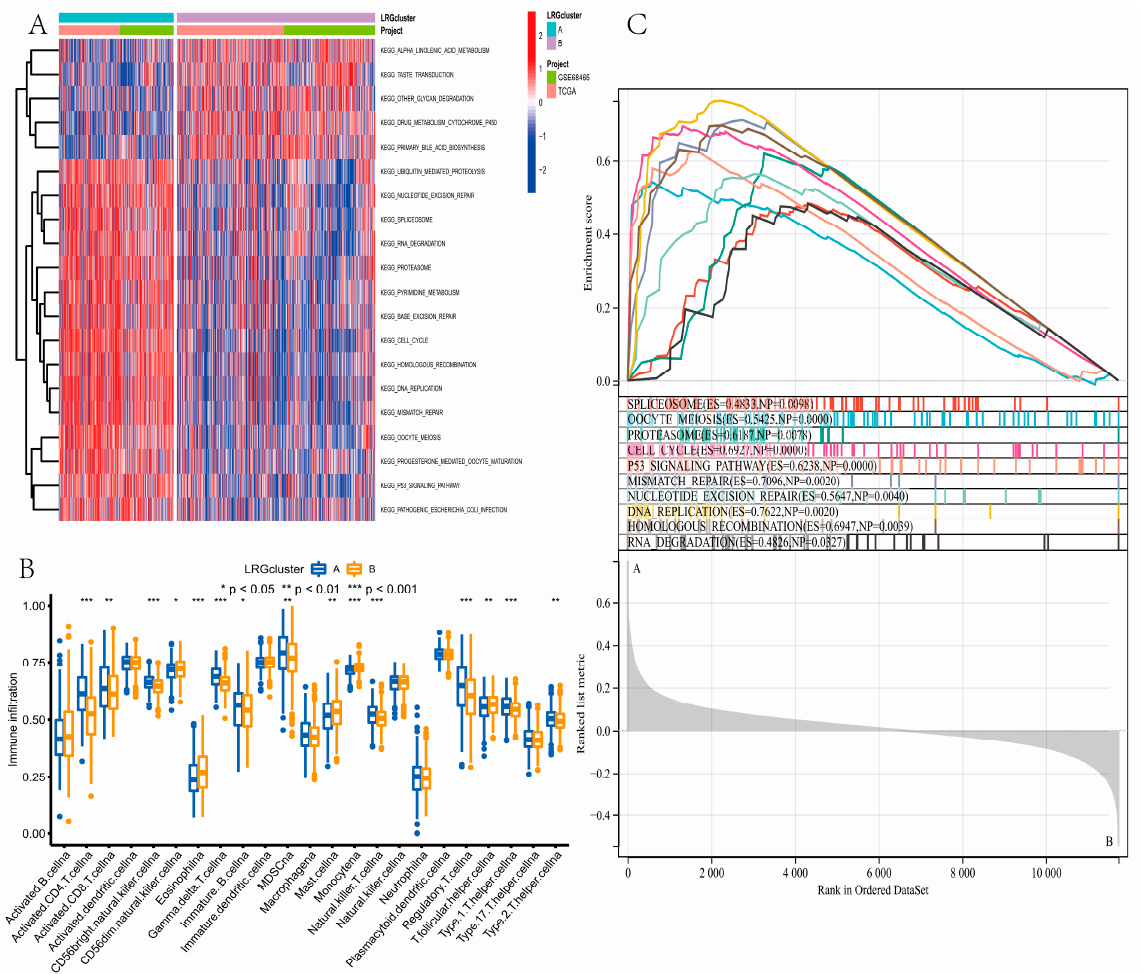
Figure 3. Correlations of tumor microenvironment (TME) and two lung adenocarcinoma (LUAD) subtypes. ( A ) GSVA of biological pathways between two distinct subtypes. LRG cluster B was enriched in alpha linolenic acid metabolism, taste transduction, other glycan degradation, drug metabolism cytochrome P450, and primary bile acid biosynthesis pathways. ( B ) Abundance of 22 infiltrating immune cell types in the two LRG clusters. Most immune cell infiltrates were significantly different between the two LRG clusters. ( C ) The results of the GSEA between LRG cluster A and LRG cluster B. * P < 0.05, ** P < 0.01, *** P < 0.001.